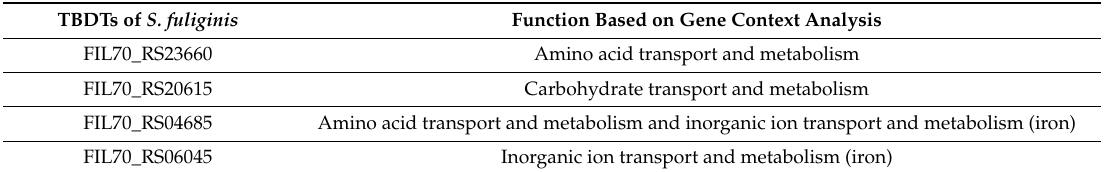
Table 3. Predicted functions of Sf TBDTs using gene context